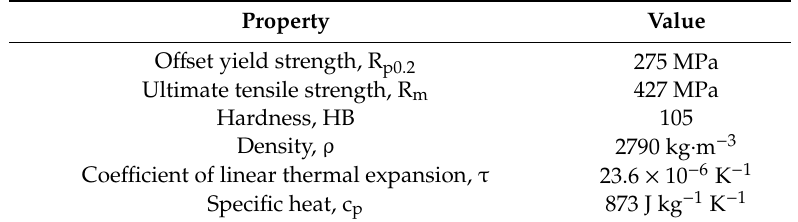
Table 1. Properties of the aluminum alloy (EN AW-2017) solution treated and normalized [21]. Property Value O ff set yield strength, R p0.2